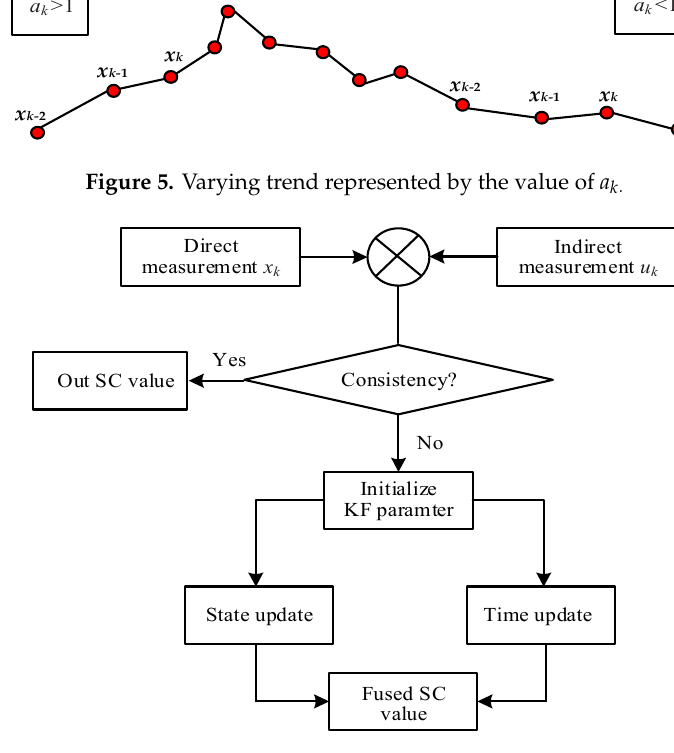
Figure 6. Flowchart of the KF approach.